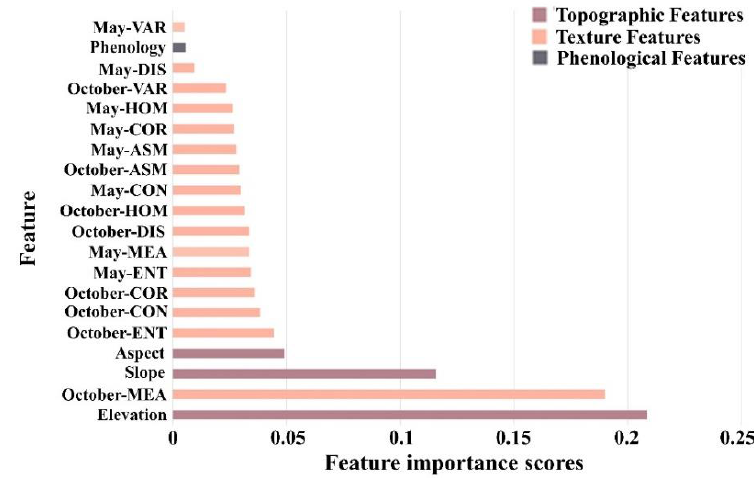
Figure 5. Random forest feature importance for tree species classification.